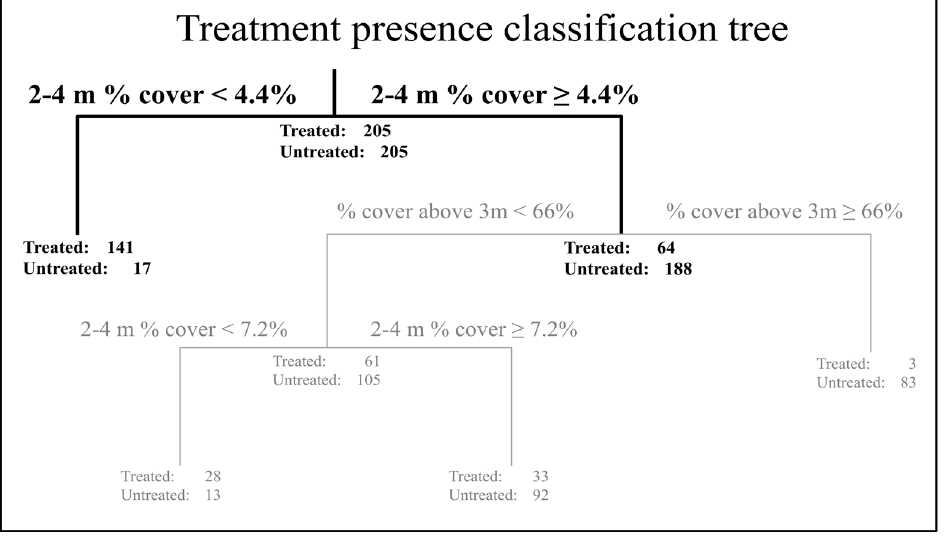
Figure 3. An example classification tree differentiating between treated and untreated cells at a sampling density of every 10th cell is shown; pruned nodes are grayed out; the only break metric in this classification was 2–4 m cover, with a break point of 4.4%; misclassification for the pruned tree can be calculated as the number of samples wrongly classified (17 + 64)/the total number of samples (410) = 19%; because there is an equal number of treated and untreated samples, the null model misclassification rate is 205/410 =